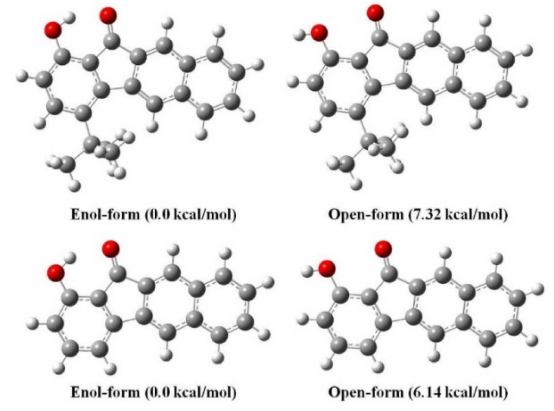
Figure 2. Computed energies of different conformers of 1 (top) and 2 (bottom) are specified relative to the respective enol-form